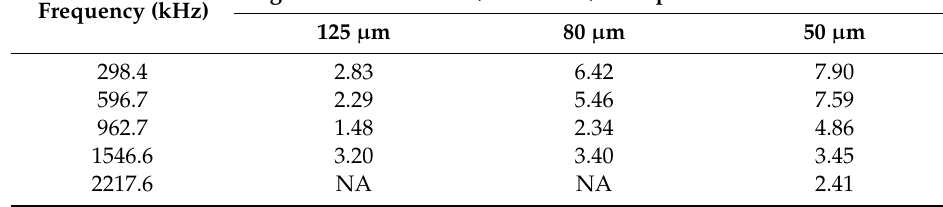
Table 1. Summary of signal-to-noise ratio values for di ff erent ultrasonic frequencies detected by the three optical fibers of di ff erent